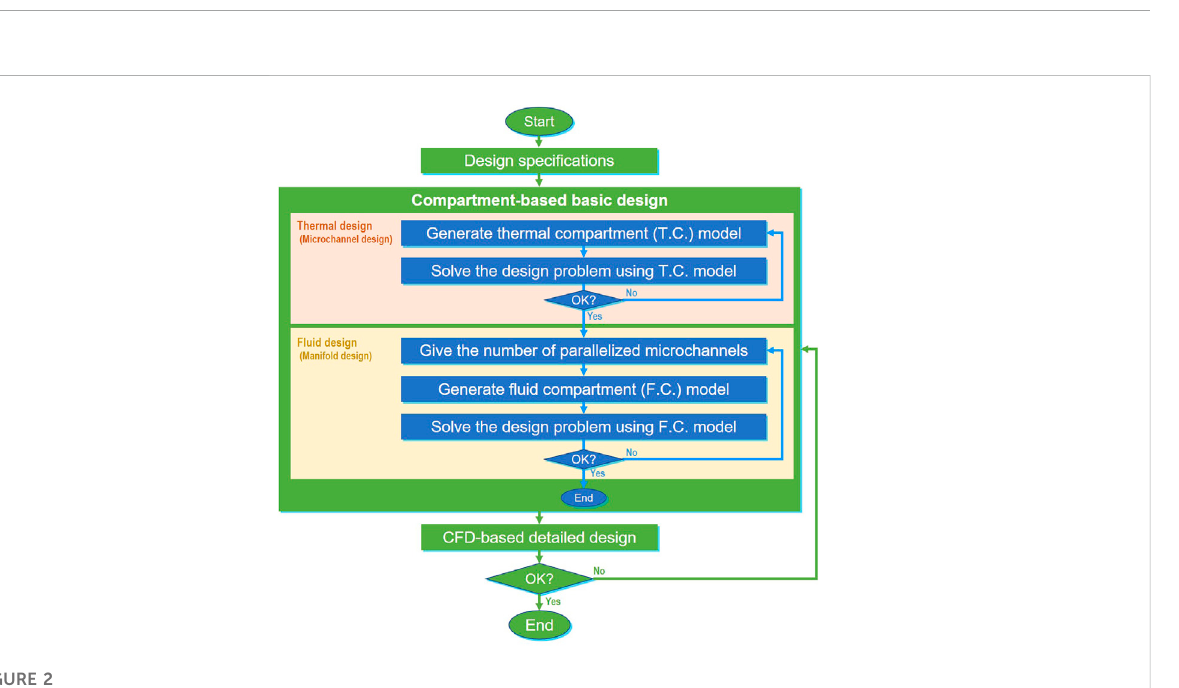
FIGURE 2 Design fl